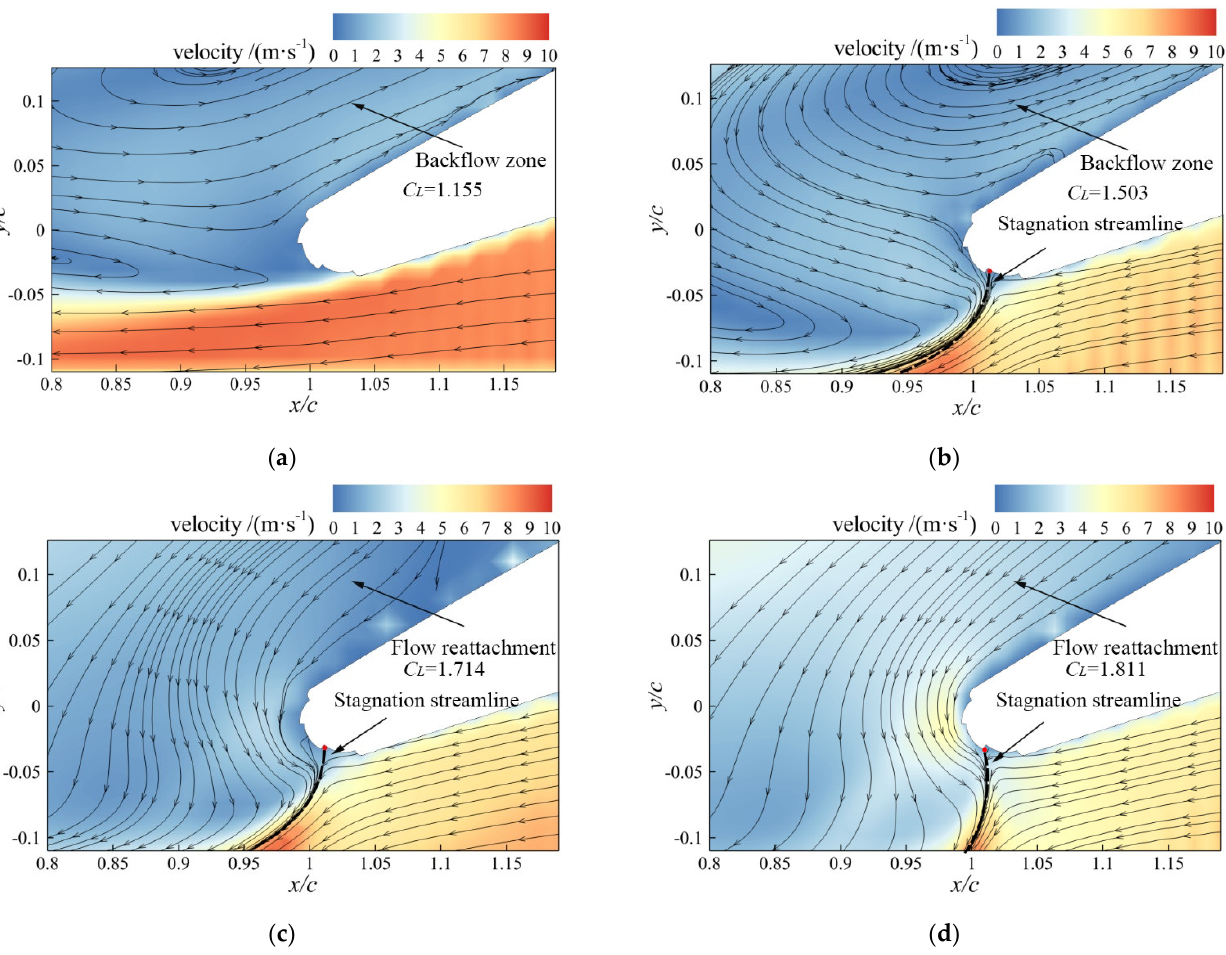
Figure 15. Comparison of velocity cloud and streamline diagrams at different blowing coefficients ( U ∞ = 8 m/s, AoA = 20°). ( a ) No Blowing. ( b ) C μ-Slot. 1 = C μ-Slot. 2 = C μ-Slot. 3 = 0.03. ( c ) C μ-Slot. 1 = C μ-Slot. 2 = C μ-Slot. 3 ficients ( U ∞ = 8 m/s, AoA = 20 ◦ ). ( a ) No Blowing. ( b ) C µ -Slot. 1 = C µ -Slot. 2 = C µ -Slot. 3 = 0.03. = 0.05. ( d ) C μ-Slot. 1 = C μ-Slot. 2 = C μ-Slot. 3 = 0.1. ( c ) C µ -Slot. 1 = C µ -Slot. 2 = C µ -Slot. 3 = 0.05. ( d ) C µ -Slot. 1 = C µ -Slot. 2 = C µ -Slot. 3 =